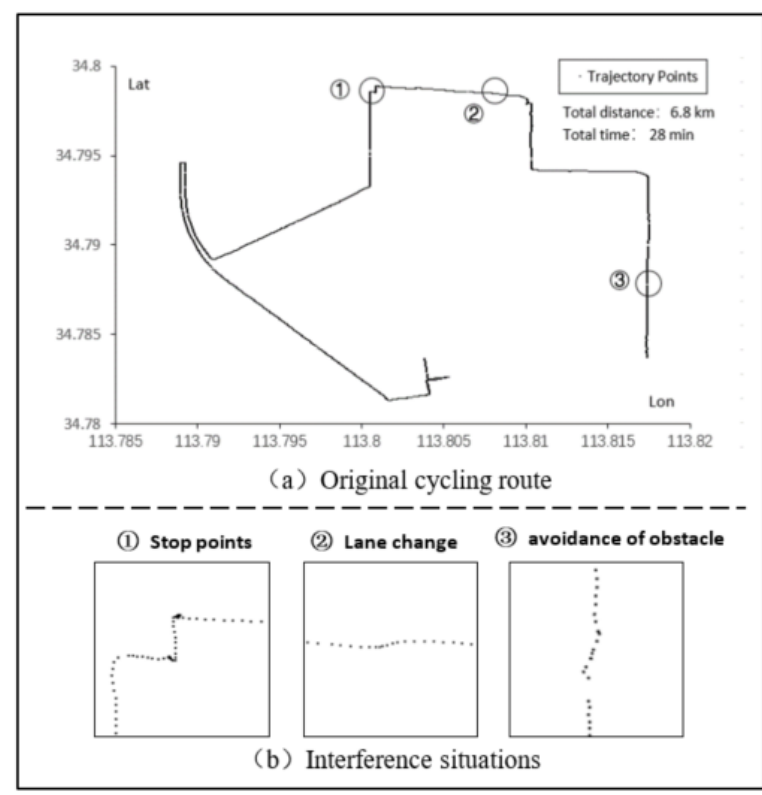
Figure 10. The second example of cycling trajectory.